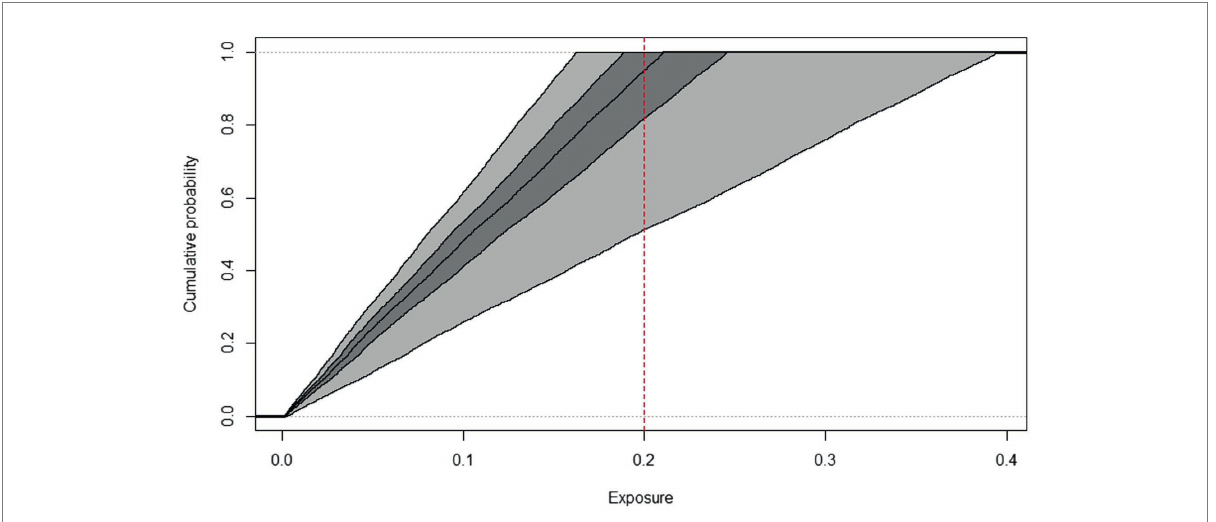
FIGURE 3 Cumulative frequency distributions of AFM1 exposure of toddlers, estimated by the 2D Monte Carlo method based on Box-Cox t distribution indicating the threshold used for HI calculation (dashed line), years 2019–2022.